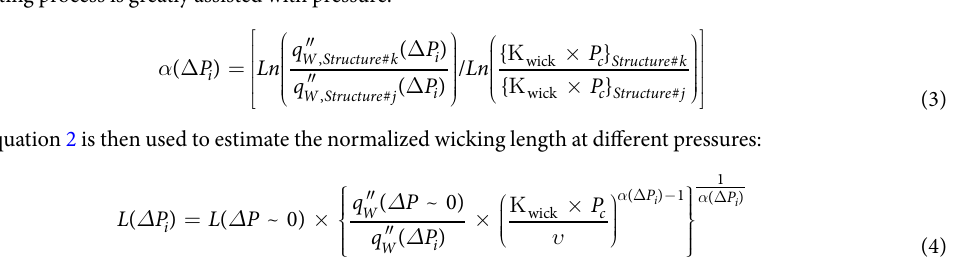
To illustrate the rate of change in wicking length, wicking lengths at different pressures ( L ( Δ P )) are normalized by minimum recorded wicking length ( L ( Δ P Burst ~ 20 kPa )) and are plotted in Fig. 7b. The trend shows a linear decline in wicking length with increasing pressure, which clearly confirms the role of pressure on limiting the lateral expansion of bubbles and vapor columns.